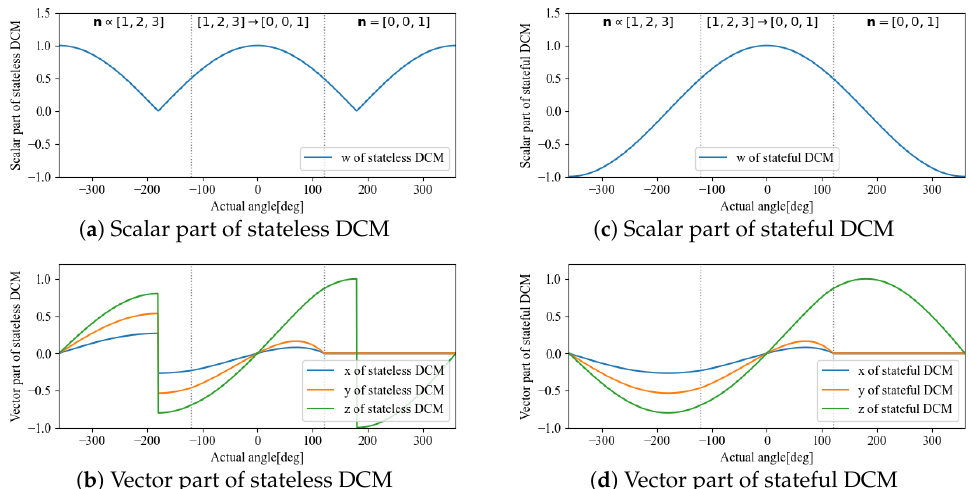
Figure 7. Comparison between stateless DCM ( left ) and stateful DCM ( right ).